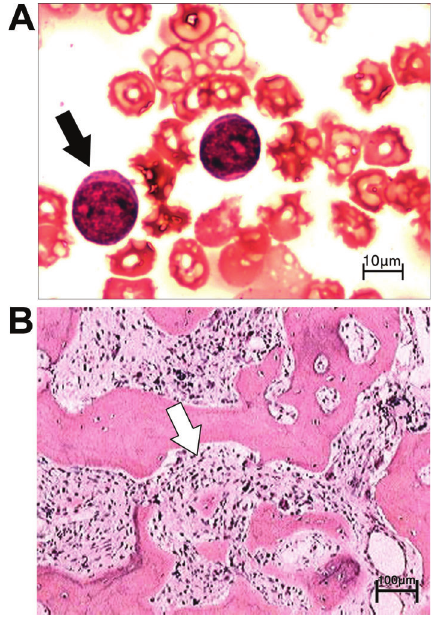
Figure 1. Bone marrow smear and biopsy of the son. A , Bone marrow smear stained with Wright-Giemsa (original magni fi cation, 1000 (cid:1) ). Black arrow: myeloblast (July 2013). B , Bone marrow biopsy stained with hematoxylin and eosin (original magni fi cation, 100 (cid:1) ). White arrow: fi broblast proliferation (July